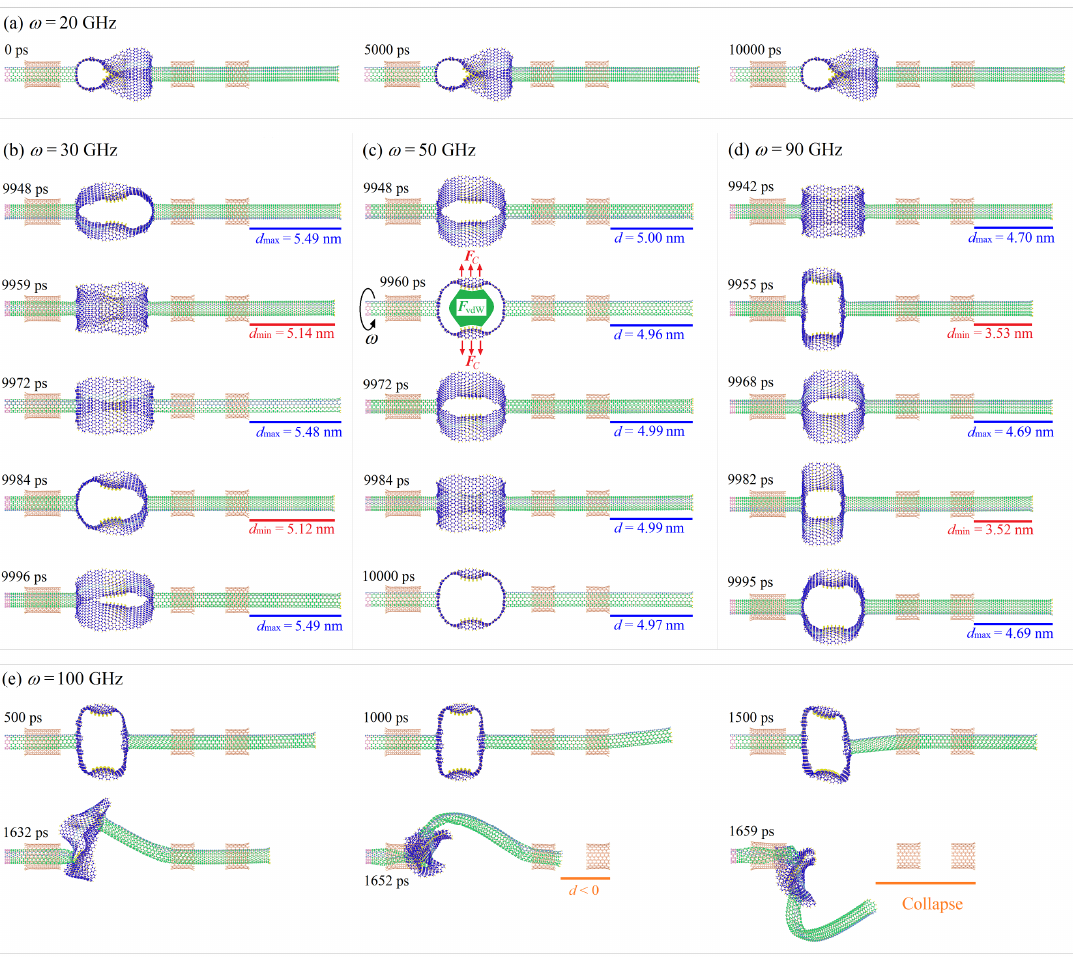
Figure 2. Configurations of the Z2H6 system under different conditions at 8 K: ( a ) ω = 20 GHz, ( b ) ω = 30 GHz, ( c ) ω = 50 GHz, ( d ) ω = 90 GHz, and ( e ) ω = 100 GHz. In (a), the HDP looked like a “ ∞ ,” and the two hydrogenated areas were in contact when ω was too low. As shown in (c), the vdW forces led to an inward curvature of the HDP, but centrifugal force pulled the atoms back. Snapshots in (e) illustrate that the system could collapse if ω was too large.